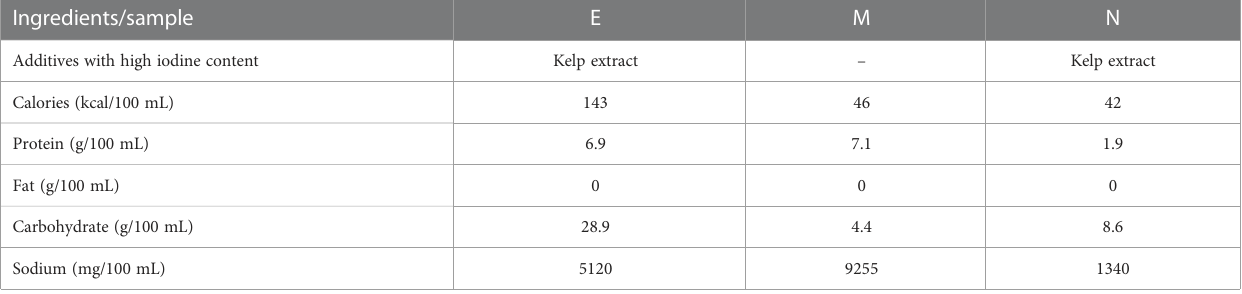
TABLE 5 Labeling of the three iodine-containing soy sauces. Ingredients/sample